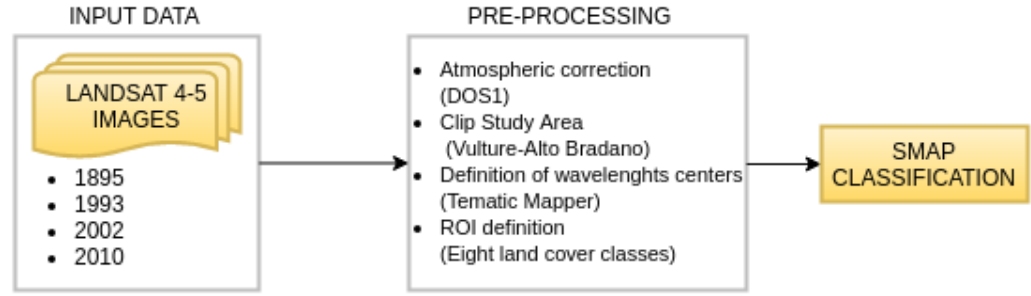
Figure 2. Flowchart of the proposed methodology. DOS, Dark Object Subtraction.